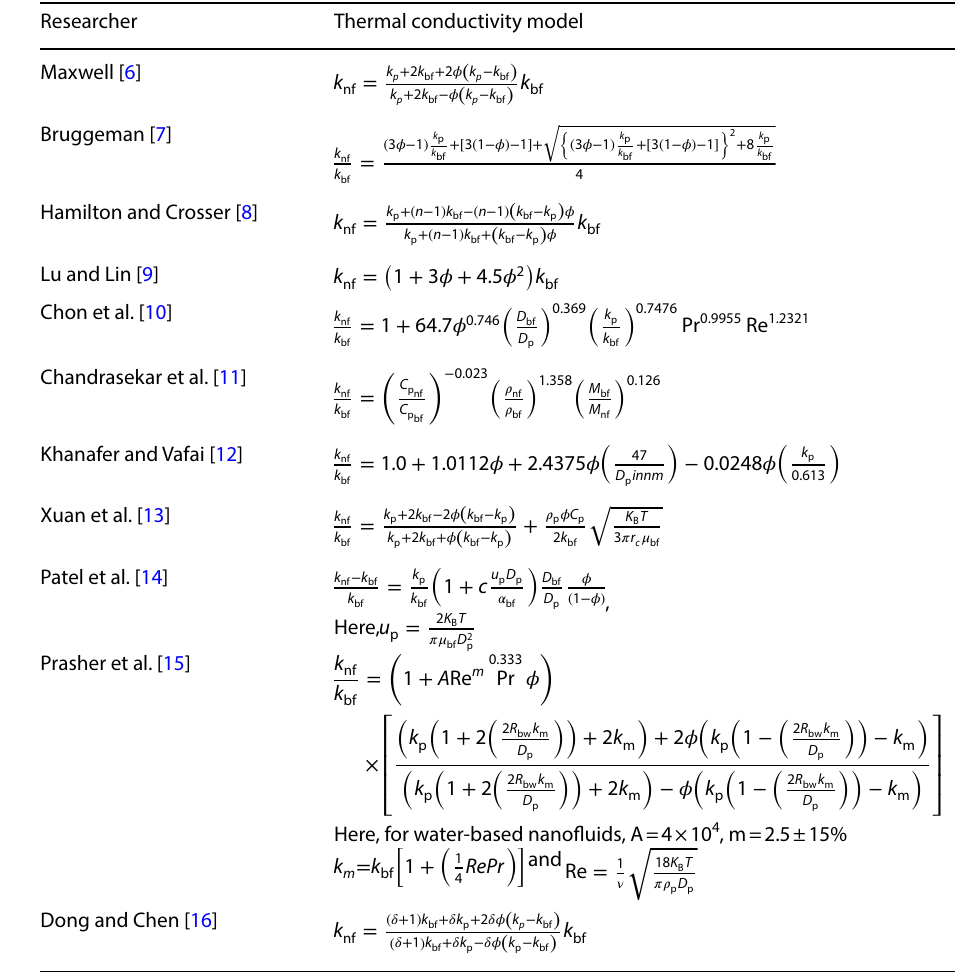
Table 2 Thermal conductivity models used for comparison as shown in Fig.